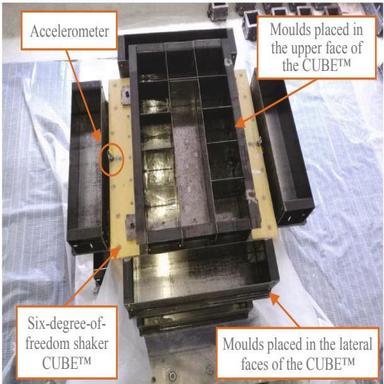
Test set-up before the cast of the mortars.